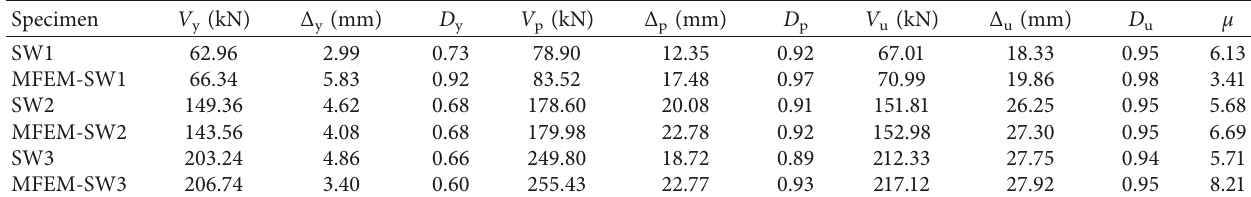
Figure 25: Result comparison of the test model and modified FEM (MFEM): (a) backbone curves and (b) damage factors. Table 4: Comparison of deformations and loads of experiment and